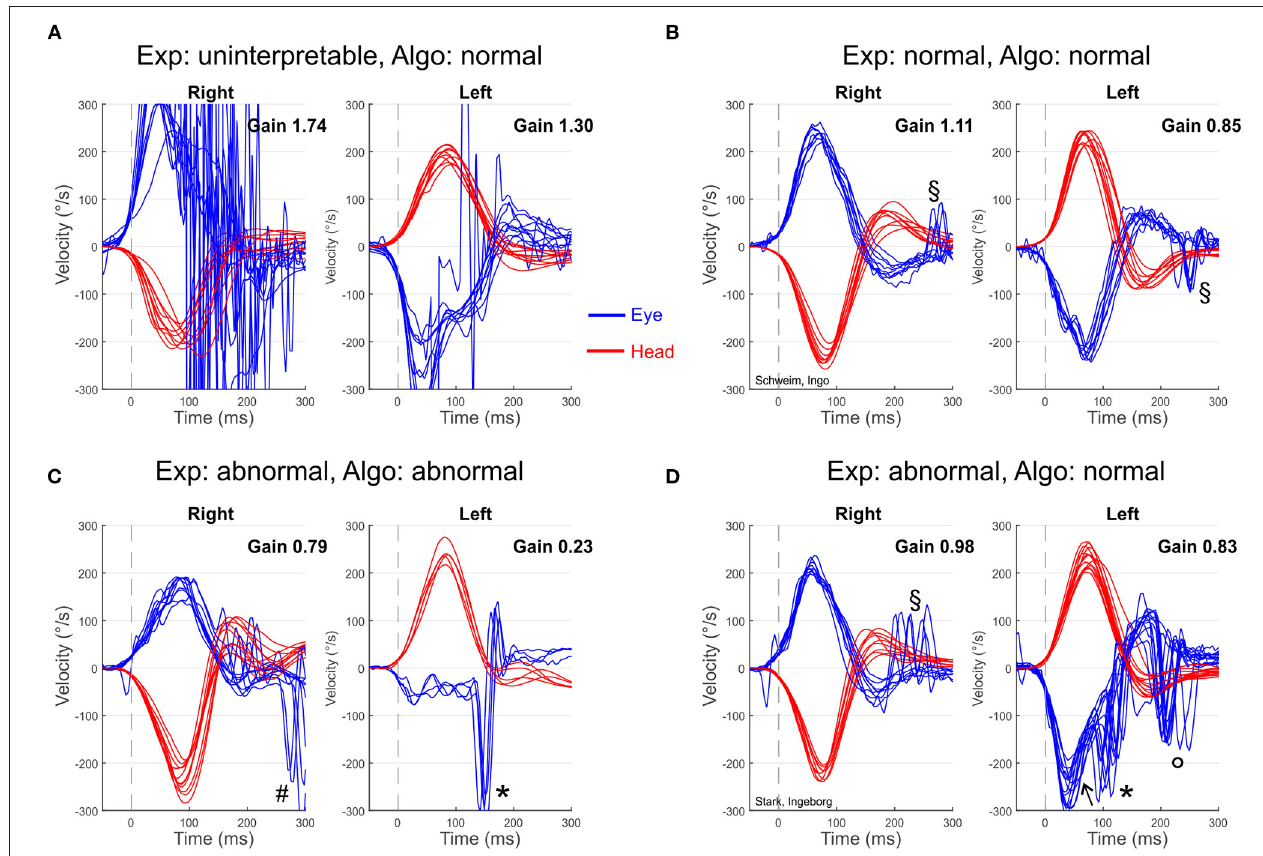
FIGURE 1 | Exemplary vHIT plots of individual patients presenting with AVS including the corresponding judgement by the experts (Exp) and the algorithm (Algo). (A) Severe artifacts (noise probably due to impaired pupil detection) and a bilateral implausible high gain (probably due to poor calibration and goggle slippage) make the vHIT of a 94-year-old women (patient ID 143) uninterpretable (experts’ judgment). The algorithm classifies it as “normal” because VOR gains are above the cutoff value of 0.7. (B) 81-year-old man (ID 169) with ischemic stroke in the territory of right posterior inferior cerebellar artery. Both the experts and the algorithm judged this vHIT as normal/central. (C) 75-year-old man (ID 30) with vestibular neuritis on the left side (MRI normal). Both the experts and the algorithm rated his vHIT as abnormal/peripheral. (D) 80-year-old woman (ID 84) with vestibular neuritis on the left side (MRI normal). The experts used additional information apart from the VOR gain (abrupt decline of eye velocity, overt/covert corrective saccades) to state a “abnormal/peripheral” VOR, while the algorithm rated this vHIT as normal/central according to the bilateral VOR gain above 0.7. *covert corrective saccade; ◦ overt corrective saccade; # anti-compensatory quick eye movement (AQEM, “wrong-way” saccade toward deficient VOR); տ Abrupt decline of eye velocity profile; § small unspecific